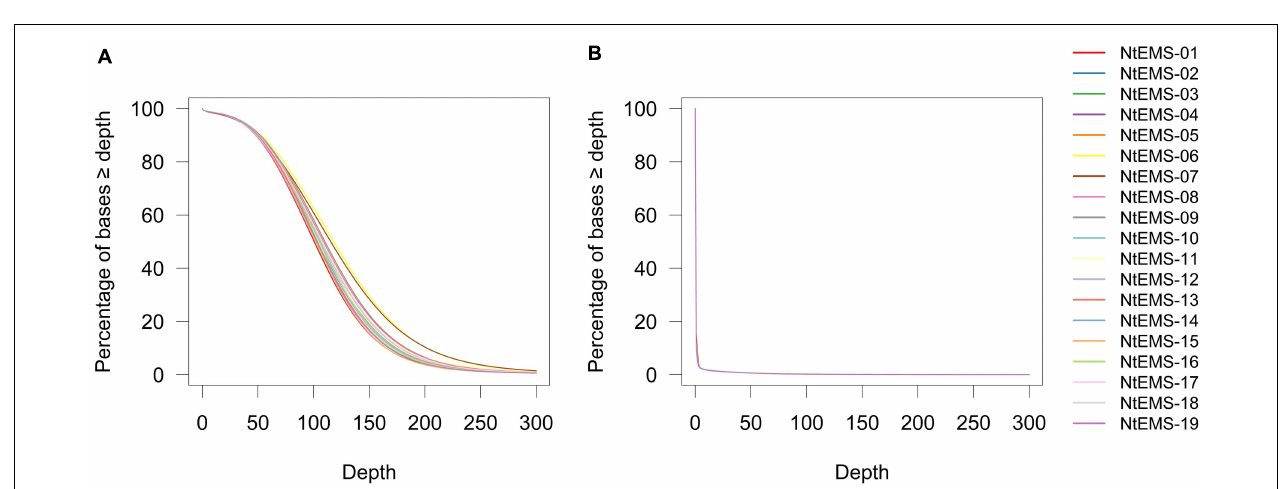
FIGURE 1 | Distribution of allelic read depth and quality scores for visually inspected mutation candidates. Mutation candidates detected by GATK (A) and BcfTools (B) were inspected using the Integrative Genomics Viewer (IGV). Quality scores are the QUAL values in the VCF outputs. Red and blue bars indicate the frequency of true positive and false positive candidates, respectively.